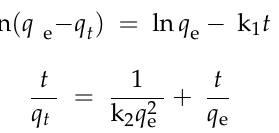
Figure 12. Adsorption kinetics of NOR on MNPC ( a ) pseudo-first-order and ( b ) pseudo-second-order models.